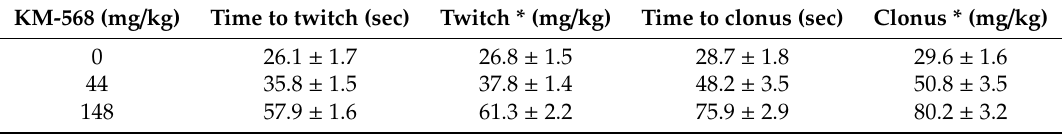
Table 4. Results of intravenous metrazol seizure threshold ( iv MET) test in mice performed after 0.25 h of i.p. administration of tested compound. Results are presented as mean ± SEM for ten animals for each dose.